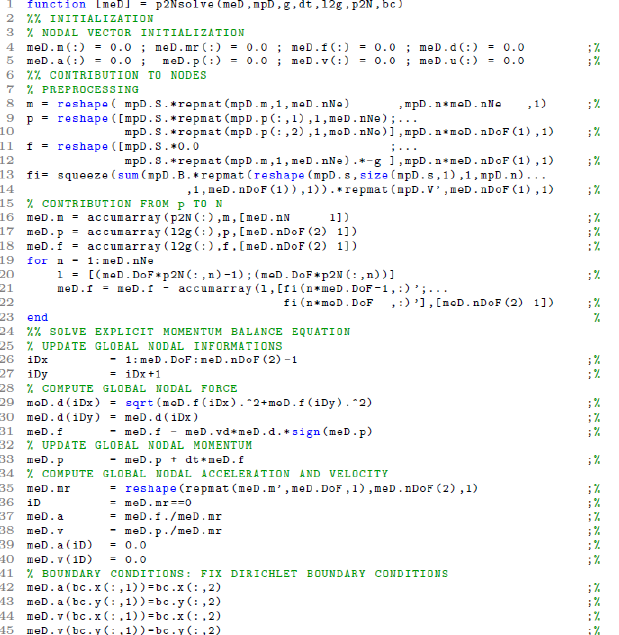
Figure 5. Code fragment 2 shows the vectorized solution to the nodal projection of material point quantities (e.g. mass and mo- mentum) within the local function p2Nsolve.m . The core of the vectorization process is the extensive use of the built-in function of MATLAB© accumarray( ) , for which we detail the main fea- tures in the text. Table B1 lists the variables used.